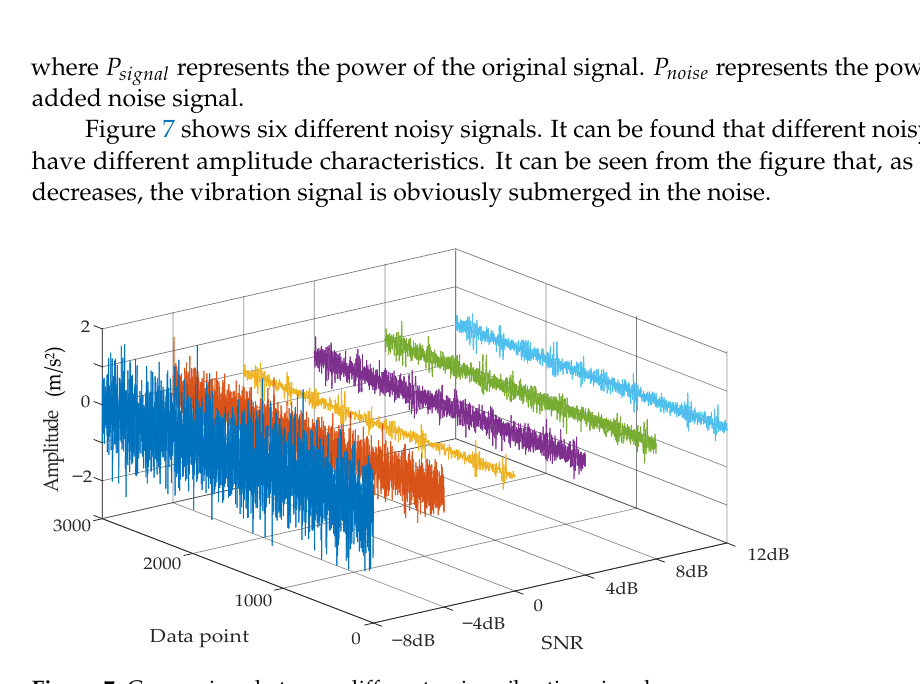
Figure 7. Comparison between different noisy vibration signals. The accuracy of the BayesianPDL framework tested under different numbers of PFRBs in different noise environments, as shown in Figure 8. The BayesianPDL frameworks with different numbers of PFRBs are trained using six kinds of noise signals. Each noisy signal is used to obtain the training dataset, the validation dataset and the testing dataset.